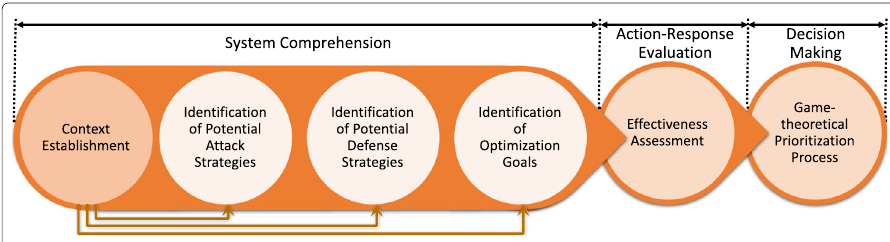
Fig. 1 Risk-based decision-support methodology for